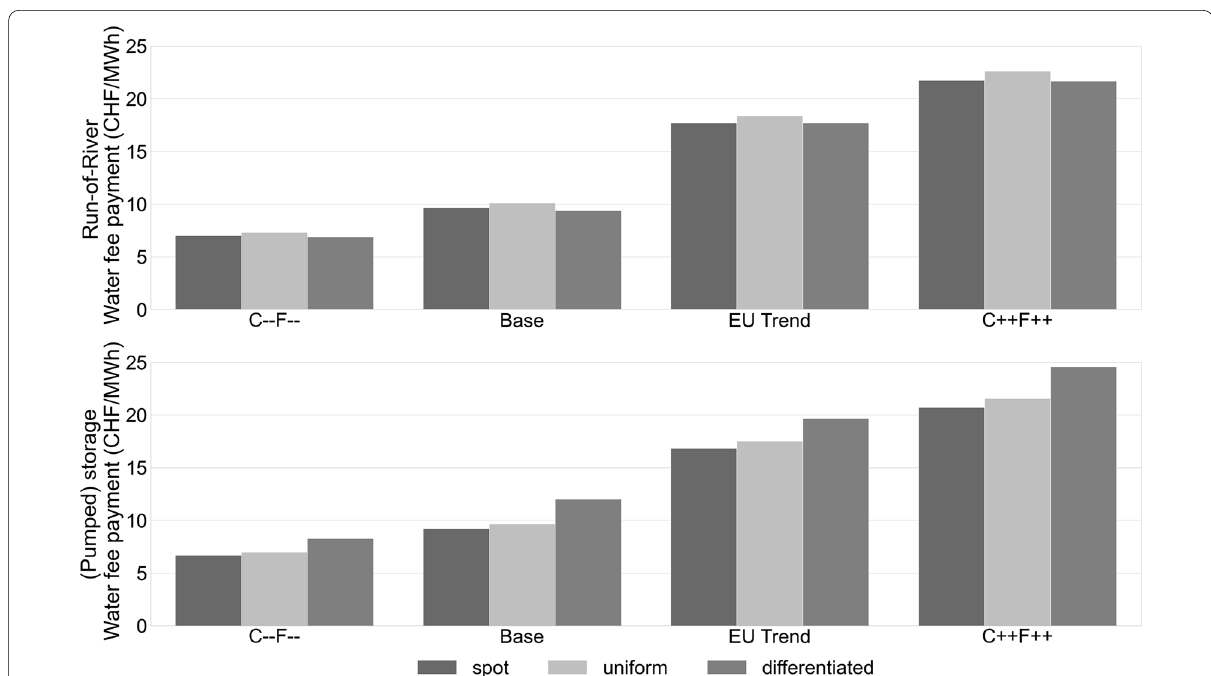
Fig. 7 Water fee payments for different reference market price options (median). Note : The market revenue for each company for a given market scenario is independent from the water fee regime and the differences shown are solely the result of the different water RMP